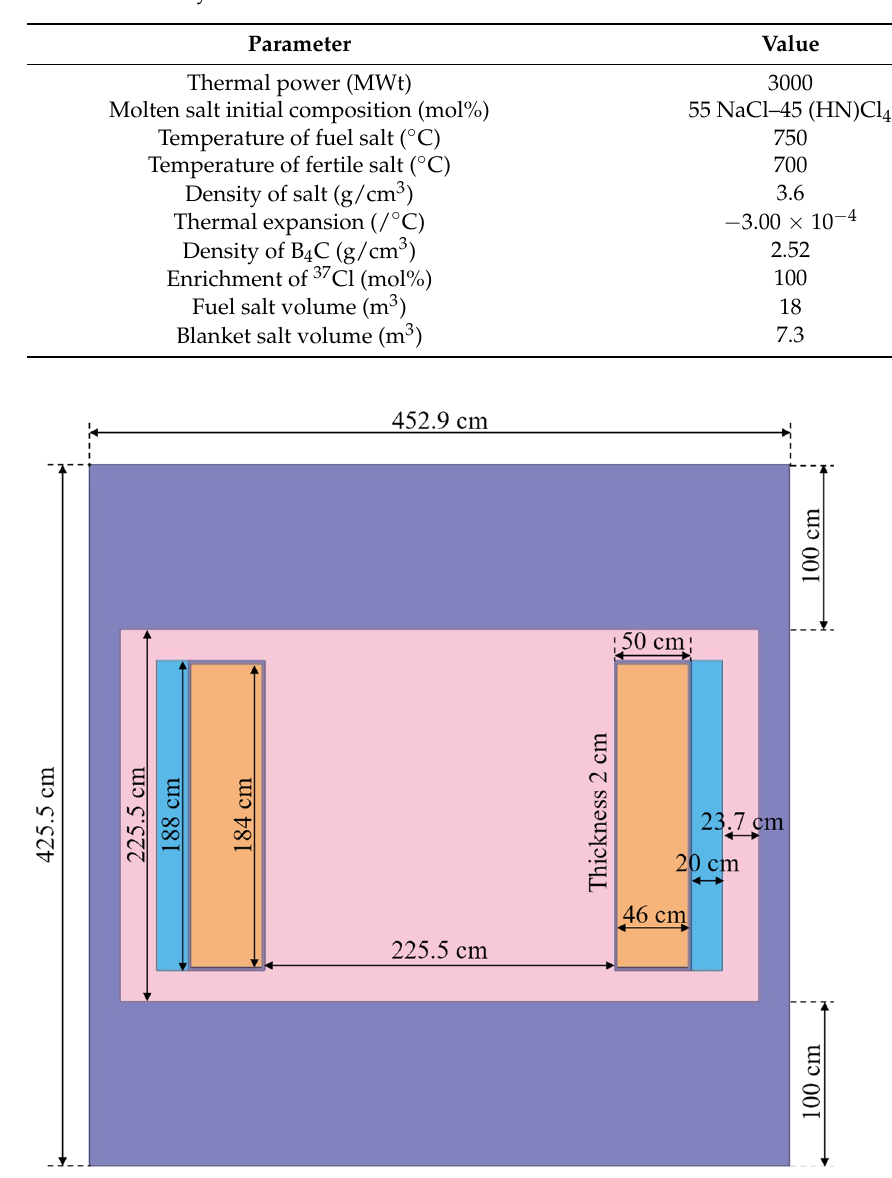
Figure 8. Structural diagram of the MCSFR’s core (unit: cm).